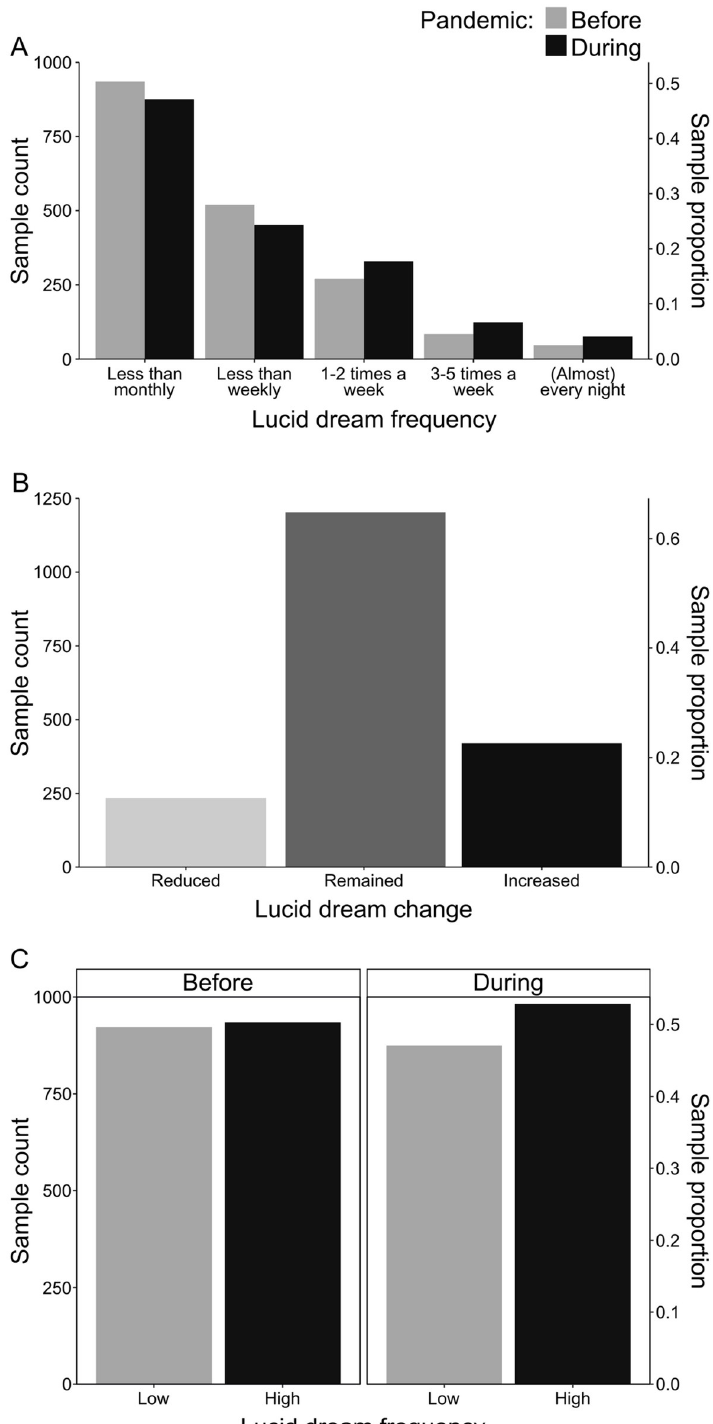
Fig 1. Descriptive analysis of the reported frequency of lucid dreams before and during the COVID-19 pandemic. (A) The number of subjects decreases as the frequency of lucid dream recall increases, but the number of frequent lucid dreamers increased during the pandemic. (B) Most participants maintained the level of declared frequency of lucid dreams despite the pandemic, but a considerable fraction of them informed that lucid dreams became more frequent. (C) When using the Gackenbach criterion for low and high frequencies of lucid dreaming, it is notable that